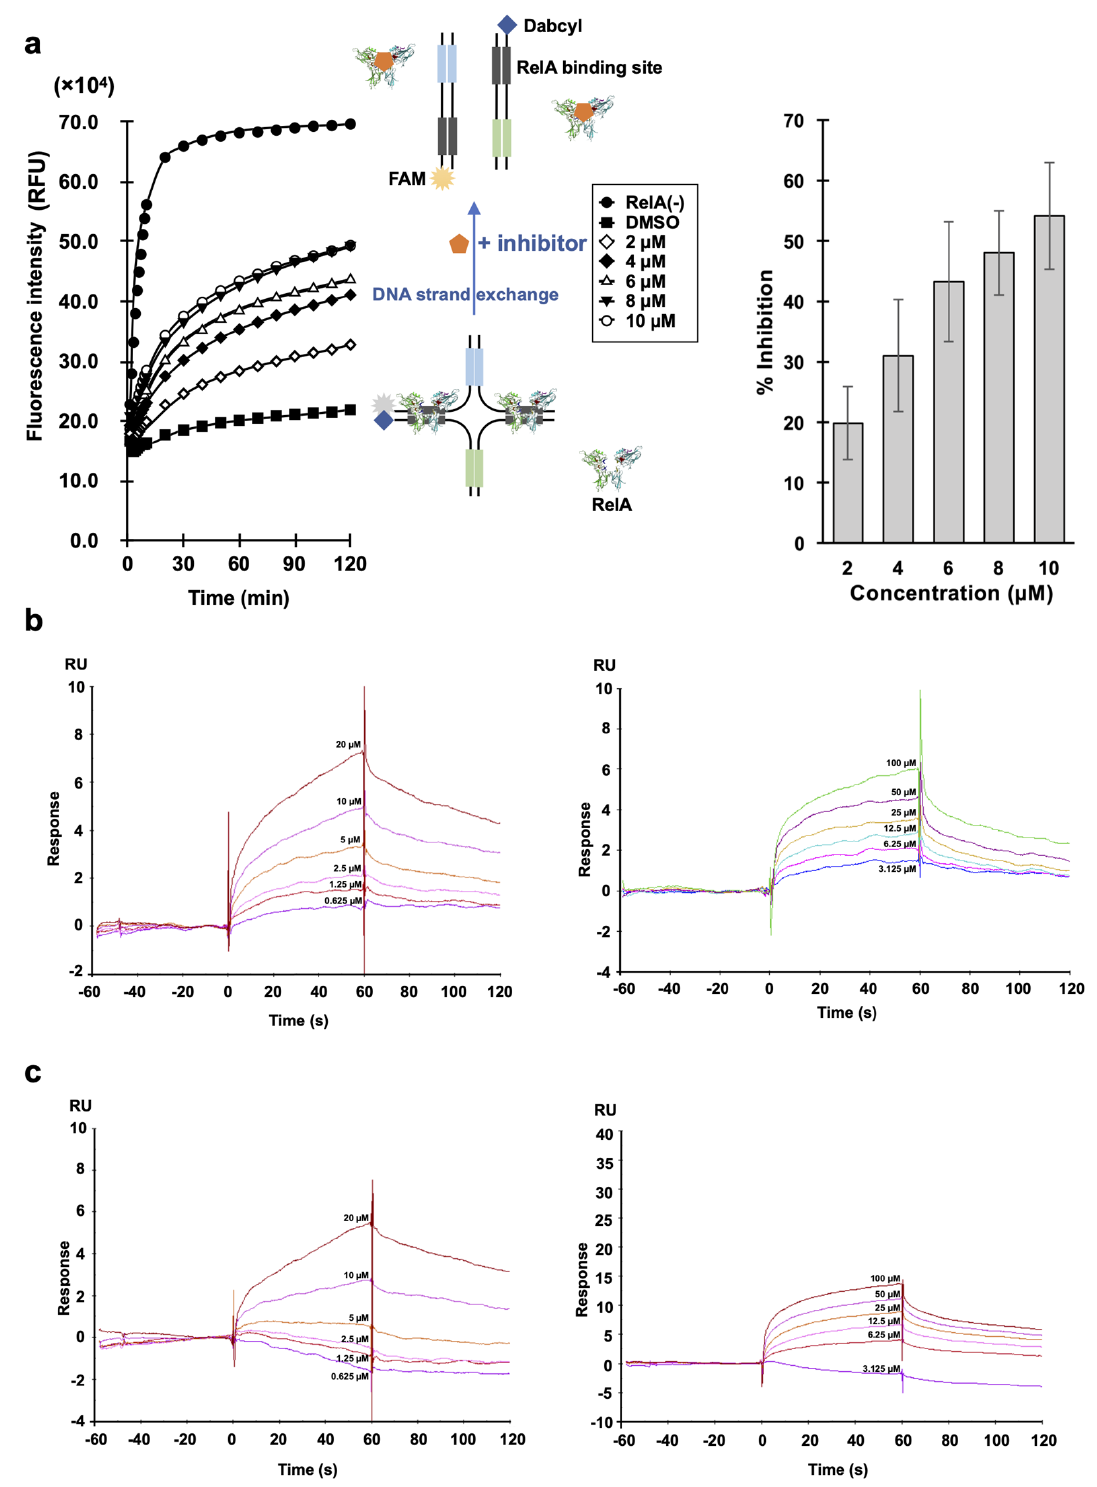
Figure 2. A55 binds to and inhibits RelA. ( a ) Dose–response of A55. Error bars represent SD ( n = 3). ( b , c ) Interaction of A55 with immobilized glutathione S-transferase (GST)–RelA or GST–p52. The figure represents surface plasmon resonance (SPR) sensorgrams using 0.625–20 µ M (left) and 3.125–100 µ M (right) of A55 with immobilized GST–RelA ( b ) or GST–p52 ( c ).